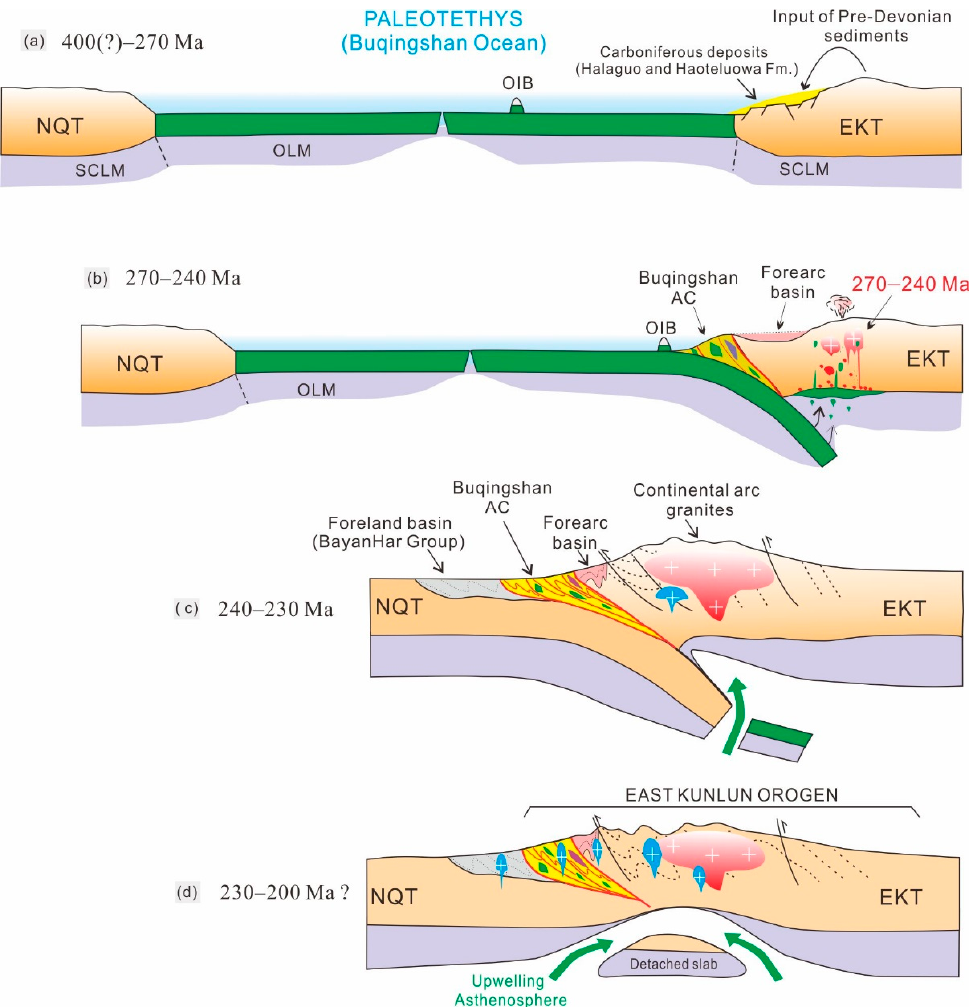
Figure 18. Cartoons showing the tectonic evolution of the Buqingshan Ocean during Late Paleozoic– Early Triassic time. ( a ) The spreading processes of Buqingshan Ocean, generating the OIBs and stable passive continental margin deposits in EKT; ( b ) subducting processes of Buqingshan Ocean, leading to the development of continental magmatic arc and forearc basin; ( c ) initial collision of the Qiangtang terrane with EKT showing the gradual tectonic emplacement of Buqingshan AC and production of minor collisional-type magmatism; ( d ) post-collisional stage showing the generation of A-type, high Sr/Y granites and delamination processes of thickening lithosphere; NQT—North Qiangtang Terrane; BT—Bayan Har Terrane; EKT—East Kunlun Terrane; SCLM—Subcontinental lithospheric mantle; OLM—Oceanic lithospheric mantle. Red color with white cross shows conti- nental arc magmatic rock, and blue color with white cross shows collisional-type magmatic rock.